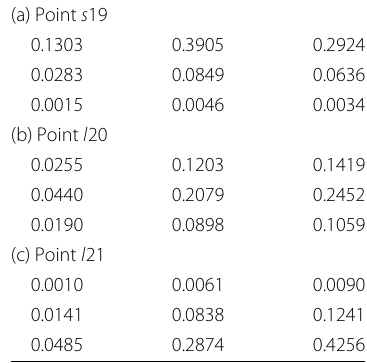
Table 6 Example trimmed patch: shape function values N i ( ξ , η ) for the integration points s 19 −